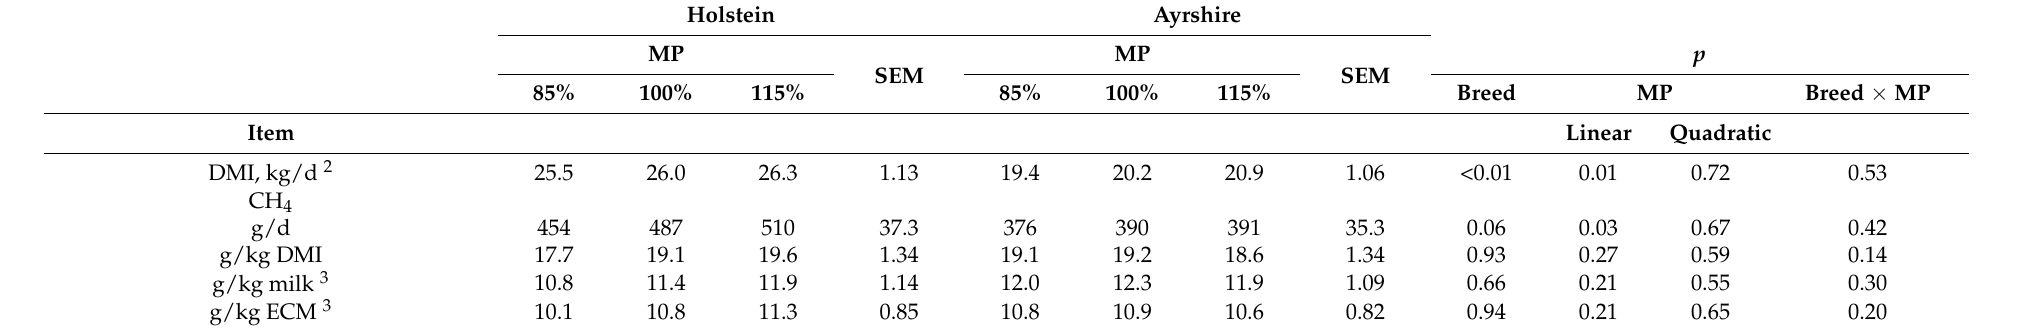
Table 6. Enteric methane production of lactating Holstein and Ayrshire cows fed diets formulated to provide 85%, 100%, or 115% of metabolizable protein (MP) requirement 1